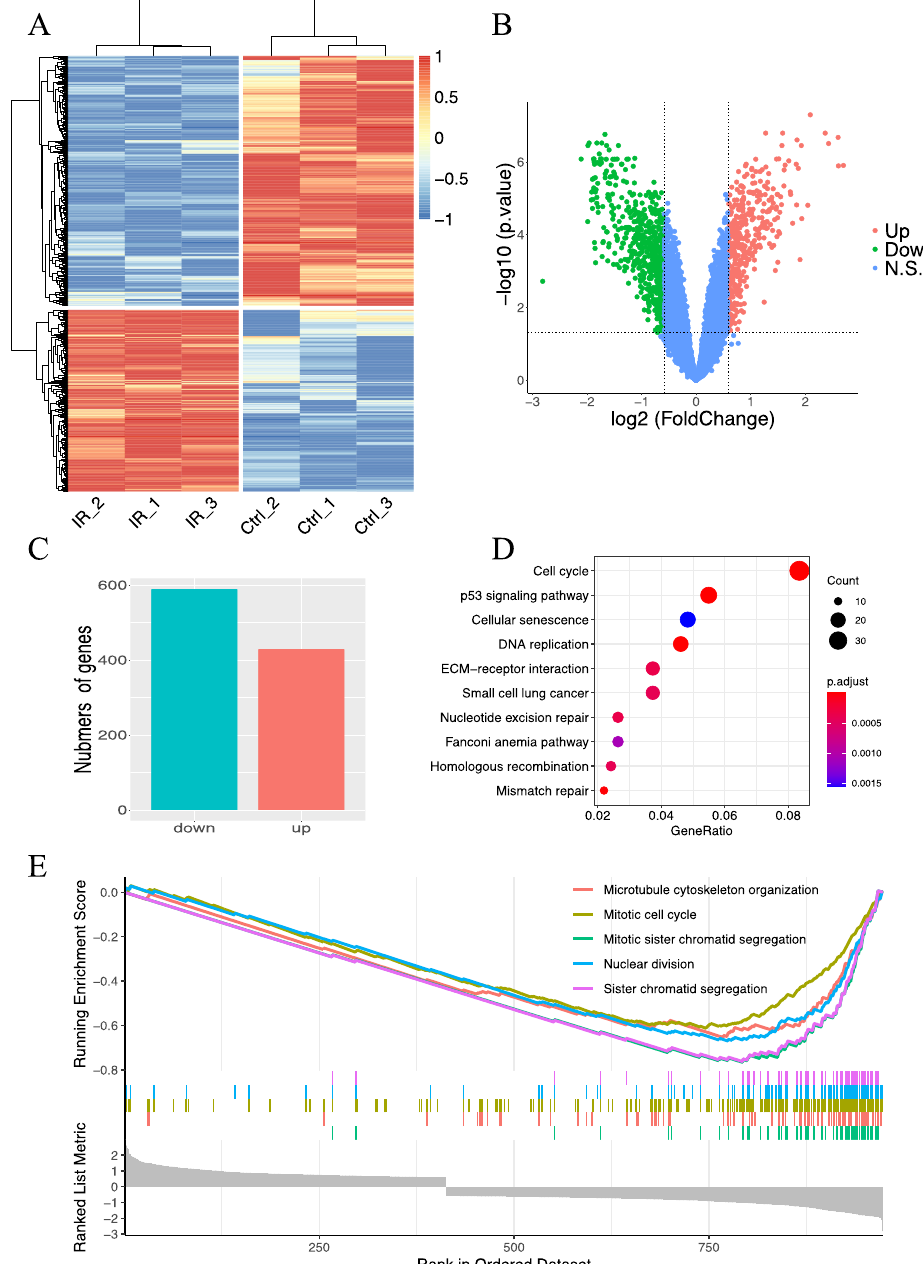
Figure 1. RNA-seq analysis of the paired irradiated and non-irradiated GBM cells in the GSE153982 dataset. ( A ) Heatmap of DEGs and normalized gene expression values were rescaled from –1 to 1. ( B ) Volcano plot of the genes. Red dots represent upregulated genes (Up), green dots represent downregulated genes (Down), and blue dots represent no significant change genes (N.S.). p < 0.05 is considered statistically significant with the threshold of fold change >1.5 or fold change <0.6667 (i.e., |log2 fold change} > 0.585). ( C ) Bar plot showing the numbers of downregulated genes (blue) and upregulated genes (red), respectively. ( D ) Top ten KEGG pathways enriched by the DEGs. ( E ) Top five gene sets enriched by DEGs based on GSEA. Abbreviations: DEG, differentially expressed gene; N.S., no significant change; KEGG, Kyoto Encyclopedia of Genes and Genomes; GSEA, gene set enrichment